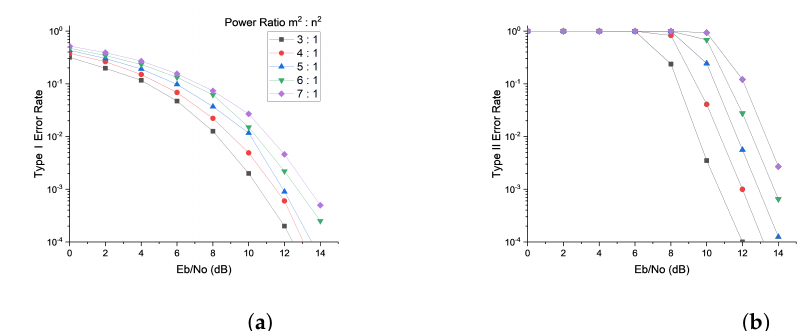
Figure 14. Acquisition performance on false positive and false negative error. ( a ) Type I Error Rate. ( b ) Type II Error Rate.